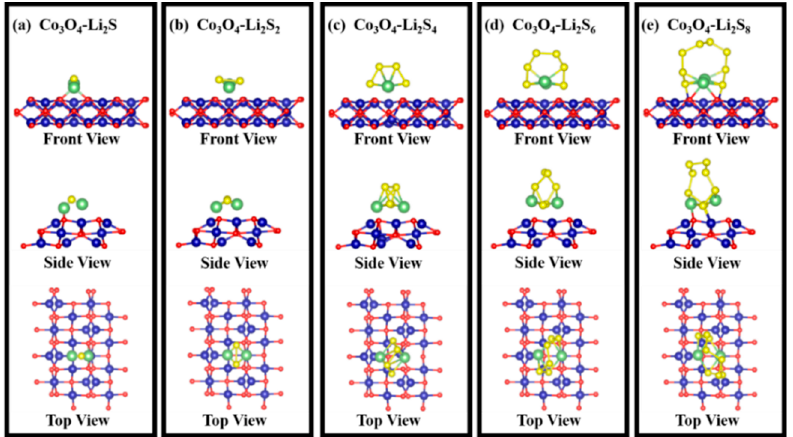
Figure 11. Adsorption models between polysulfides and Co 3 O 4 (110) surface: ( a ) Co 3 O 4 -Li 2 S; ( b ) Co 3 O 4 -Li 2 S 2 ; ( c ) Co 3 O 4 -Li 2 S 4 ; ( d ) Co 3 O 4 -Li 2 S 6 ; ( e ) Co 3 O 4 -Li 2 S 8 .